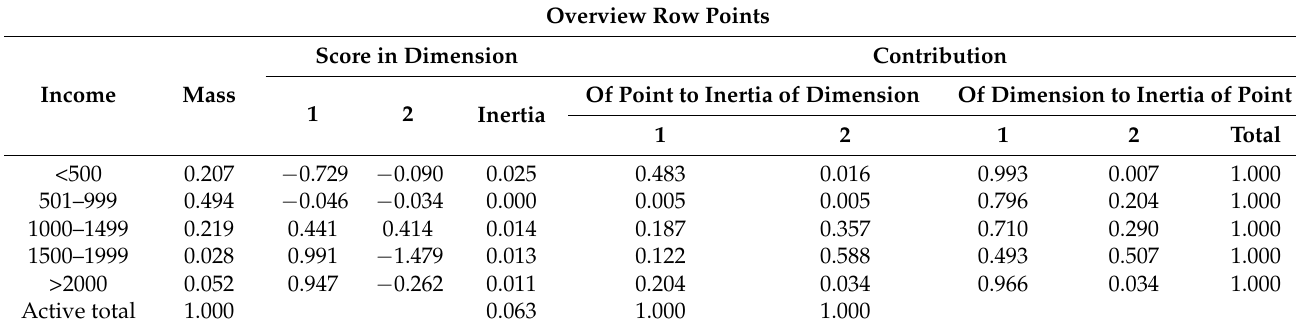
Table 4. Overview of row points (categories of income). Overview Row Points